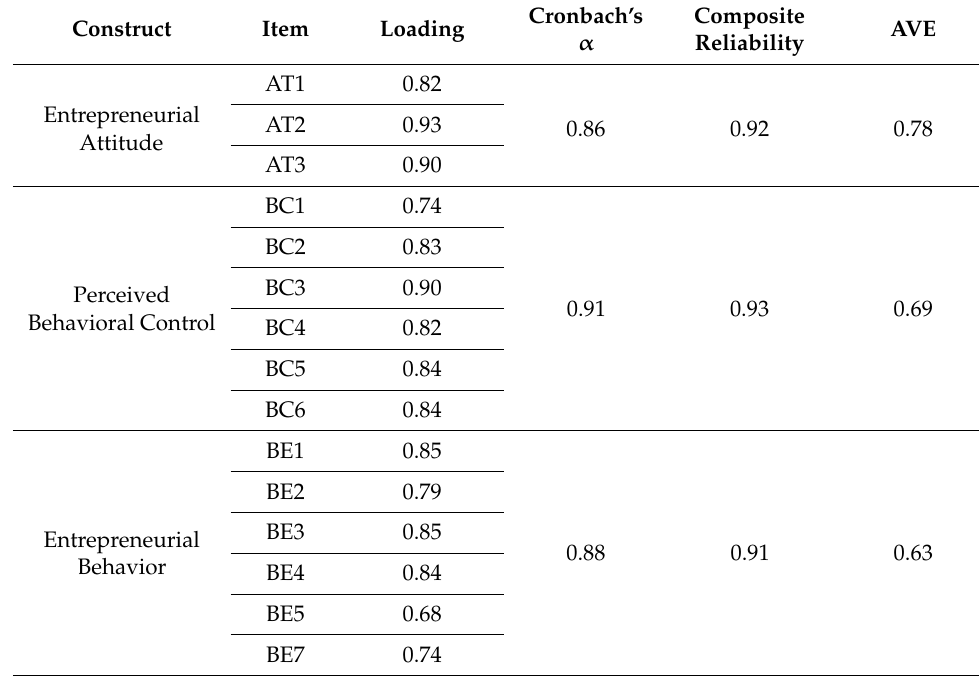
Table 1. Results of outer model’s convergent